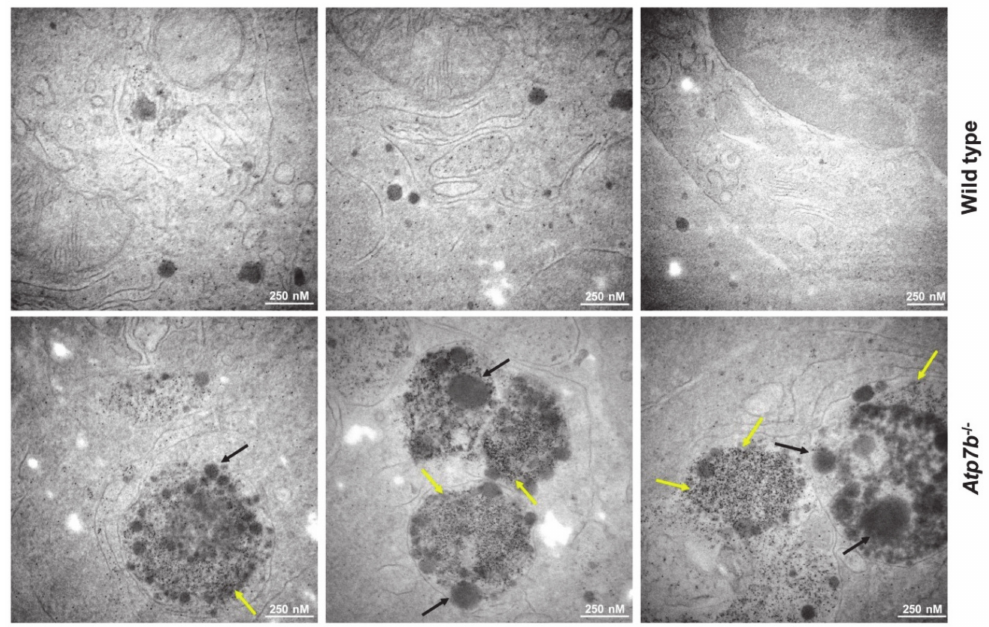
Figure 2. Electron microscopic analysis of liver sections. Representative liver pieces from wild type and Atp7b – / – mice were fixed and examined by electron microscopy. The Atp7b – / – samples show frequent electron-dense deposits (yellow arrows) and huge fat droplets (black